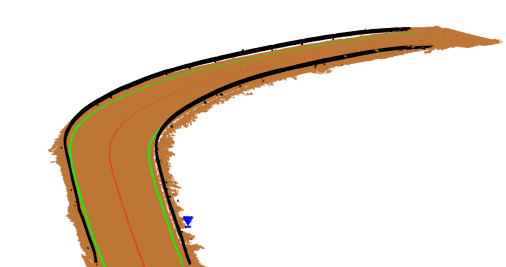
Figure 3. Semantic segmentation of a conventional road section. Road edges (green), alignment (red), guardrails (black) and traffic signs (blue) are